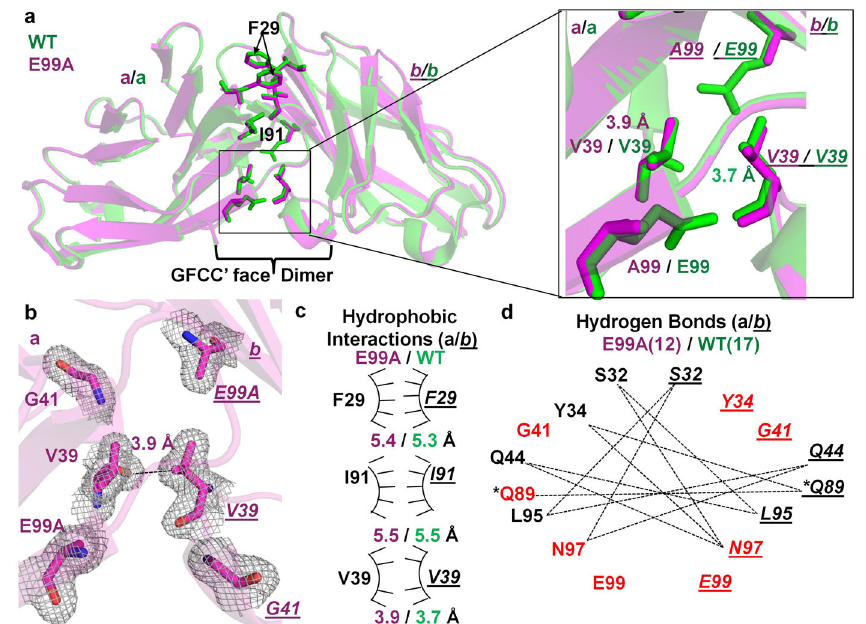
Fig. 2 Crystal structure E99A IgV mutant of hCEACAM1. a The ribbon diagram of the E99A mutant (magenta) and WT (green) crystal structures with molecules (a) and ( b ) superimposed on each other. The labeled residues of molecule (a) and molecule ( b ) are shown by stick representation. The inset shows the superimposition of A99 and V39 residues of the E99A mutant (magenta) on E99 and V39 residues of the WT (green), where higher distance of 3.9 Å (magenta) between the β carbons of V39 residues was observed in the E99A mutant structure compared to distance of 3.7 Å (green) between the β carbons of V39 residues of the WT. The residues of molecule ( b ) are shown in italics and underlined, here and throughout. b The stick representation of E99A, V39 and G41 residues of molecules (a) and ( b ) with electron densities (2Fo – Fc map at 1.0 σ level) as observed in the E99A mutant structure, which depicts loss of critical intermolecular hydrogen bonds between E99A and G41 as observed in the WT structure between the backbone amide of residue G41 with the side chain carboxyl group of residue E99. The hydrogen bond (3.9 Å) between β carbons of V39 residues as observed in the E99A mutant is shown by dashed lines. The carbon atoms in magenta, carbonyl oxygen in red, and nitrogen in blue, are colored, respectively. c The arc/stick representation of hydrophobic interactions by F29, I91, and V39 residues of molecules (a) and ( b ) as observed in the E99A crystal structure (magenta) compared to the WT (green). The hydrophobic interactions as measured by distance between β carbons of labeled residues are shown in magenta and green for E99A mutant and WT, respectively. The weaker hydrophobic interactions mediated between two V39 residues are shown by fewer pointers on the hydrophobic arc relative to WT. d The hydrogen bonded interactions (dashed lines) mediated by GFCC ′ face labeled residues as observed in the E99A mutant structure. The lesser quantity of hydrogen bonds at GFCC ′ interface were observed in the E99A mutant structure, 12 (magenta) vs 17 (green) for E99A and WT, respectively. The residues in red highlight the residues involved in the complete loss or decreased number of hydrogen bond formed in the E99A mutant structure compared to WT. The asterisk (*) indicates formation of two hydrogen bonds (shown by single dashed line) mediated by Q89 residues of molecule (a) and ( b ) with each other via OE1 and NE2